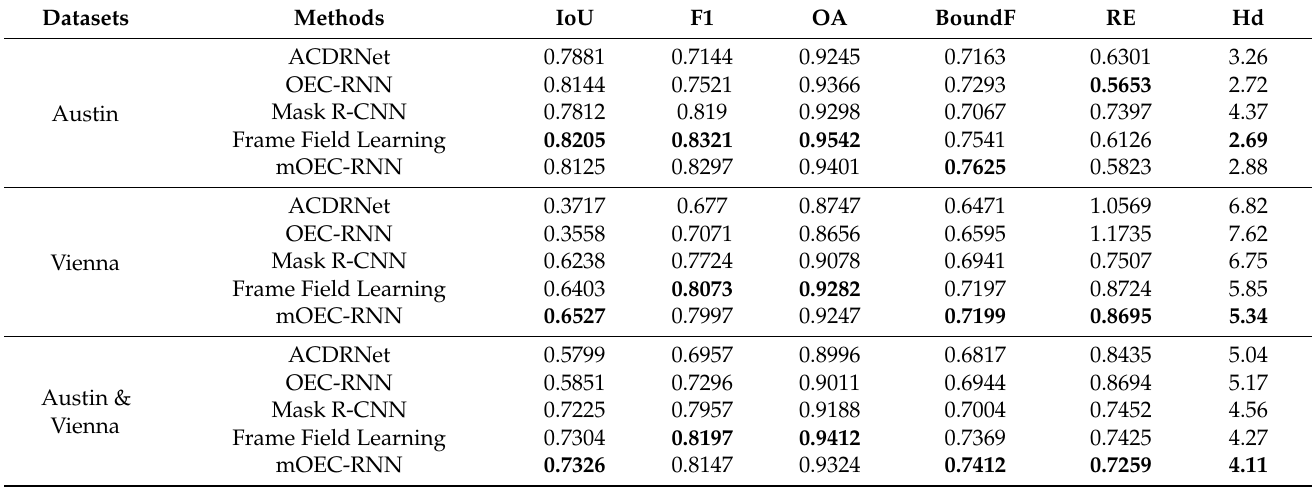
Table 1. Quantitative evaluation results.